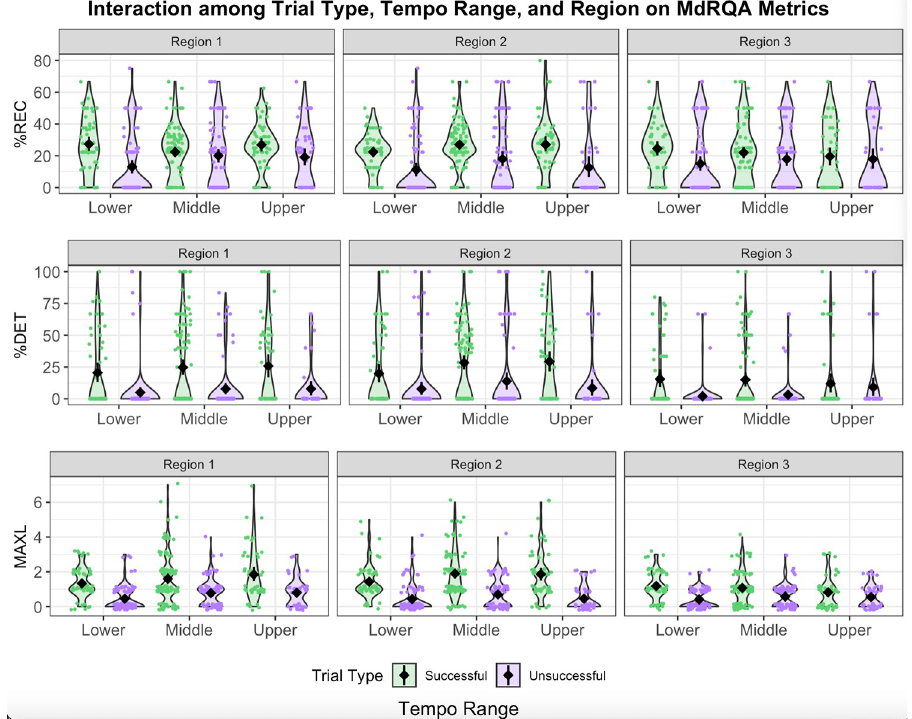
Fig 4. Effects of trial type (green: Successful; purple: Unsuccessful), tempo range, and region on MdRQA metrics: %REC (Panel A, top), %DET (Panel B, middle), and MAXL (Panel C, bottom). The metronome ranged from 80– 140 bpm. In our linear mixed effects model, we binned tempo into the following categories: lower (80–90 bpm), middle (100–120 bpm), and upper (130–140 bpm). The violin plots depict the probability density of the binned tempo data at different %REC, %DET, and MAXL values. The mean value is indicated by a diamond near the center of each violin. Results of statistical analyses are located in Table 4.